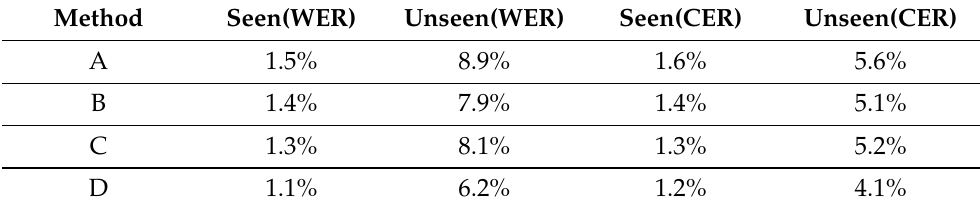
Table 4. Comparison between different